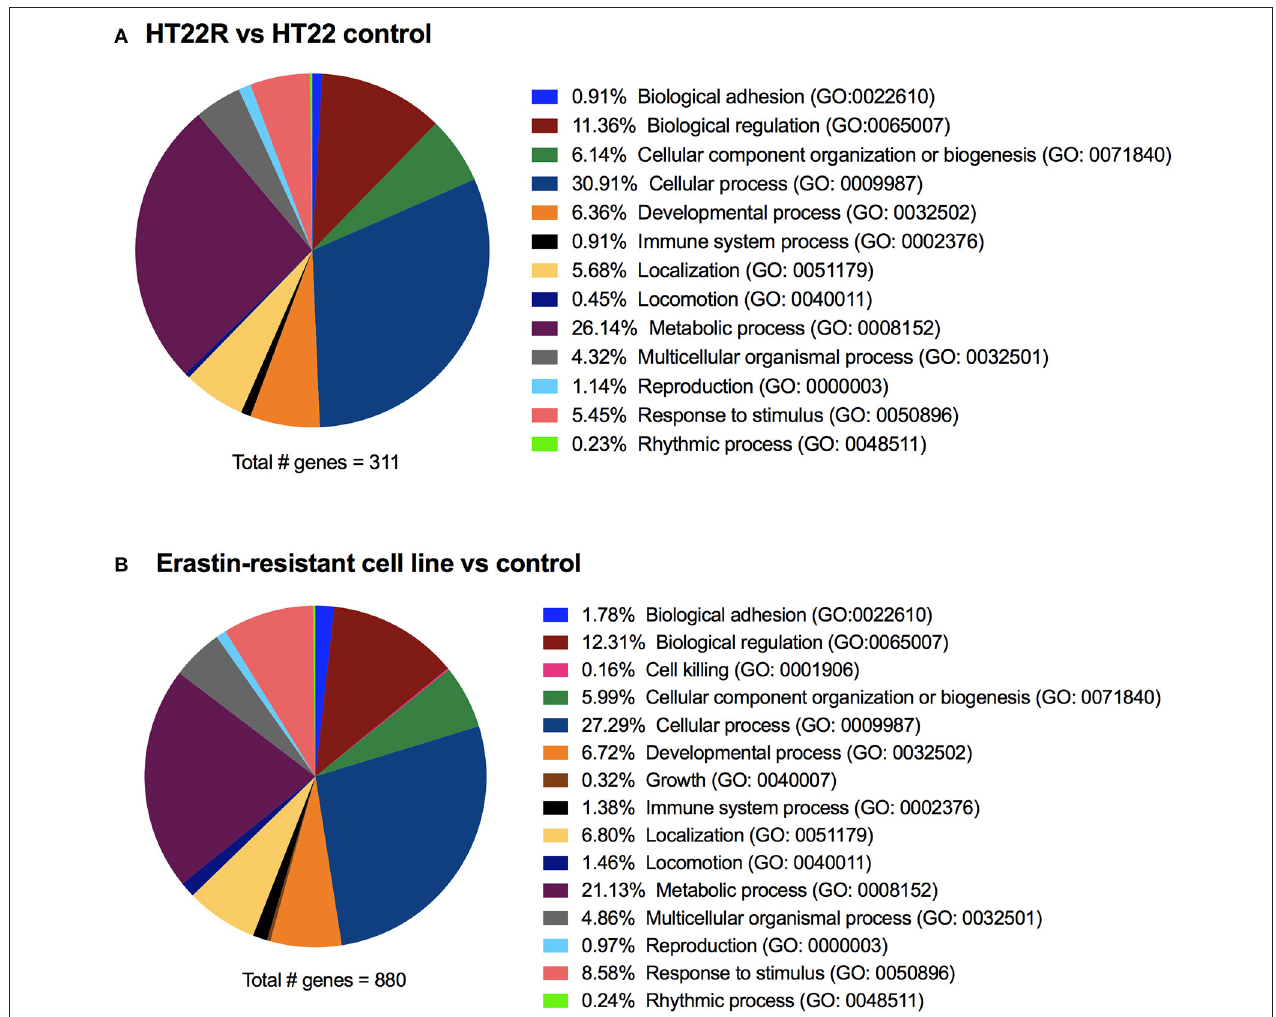
FIGURE 3 | Transcriptome changes in acquired oxytosis and ferroptosis resistance. The transcriptomes of HT22 cells selected for resistance to oxytosis induced by glutamate (HT22R) (A) and DU-145 human prostate cancer cells selected for resistance against ferroptosis induced by erastin (B) (Dixon et al., 2014) were compared to their parental oxytosis/ferroptosis sensitive cell lines. Using the Panther classification system, deregulated genes ( = fold-change ≥± 2) are grouped into biological processes. Both cell lines have highly similar deregulation profiles, even though the total number of deregulated genes differs greatly. The erastin-resistant cell line shows (minor) deregulation in only two additional processes compared to the HT22R. These processes (cell killing and cell growth) are likely to be attributed to the cancerous origin of this cell line. Gene Ontology (GO) identifications are shown between